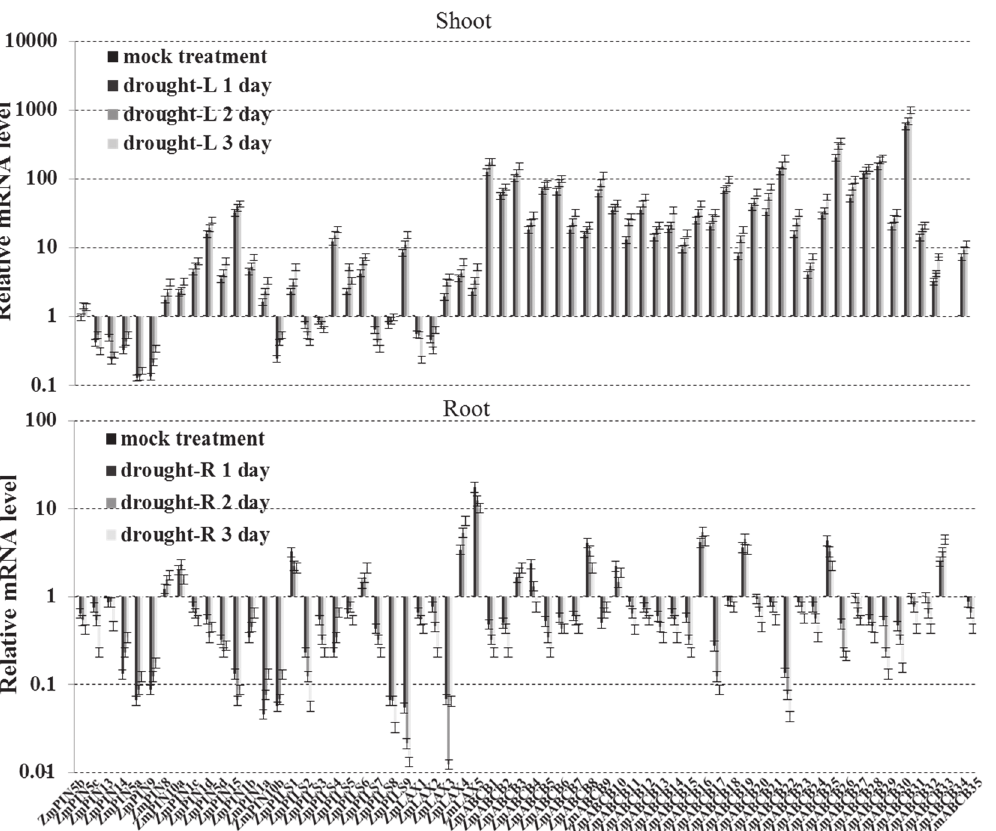
Fig 6. Expression levels of ZmPIN , ZmPILS , ZmLAX and ZmABCB gene families in response to drought. Expression levels of ZmPIN , ZmPILS , ZmLAX and ZmABCB genes were analyzed by qRT-PCR in both shoot (A) and roots (B) of 14-day-old seedlings, which were treated with dry sand treatment (drought) for 3 days. The relative expression levels were normalized to a value of 1 in mock seedlings. Error bars represent SD from five biological replicates.